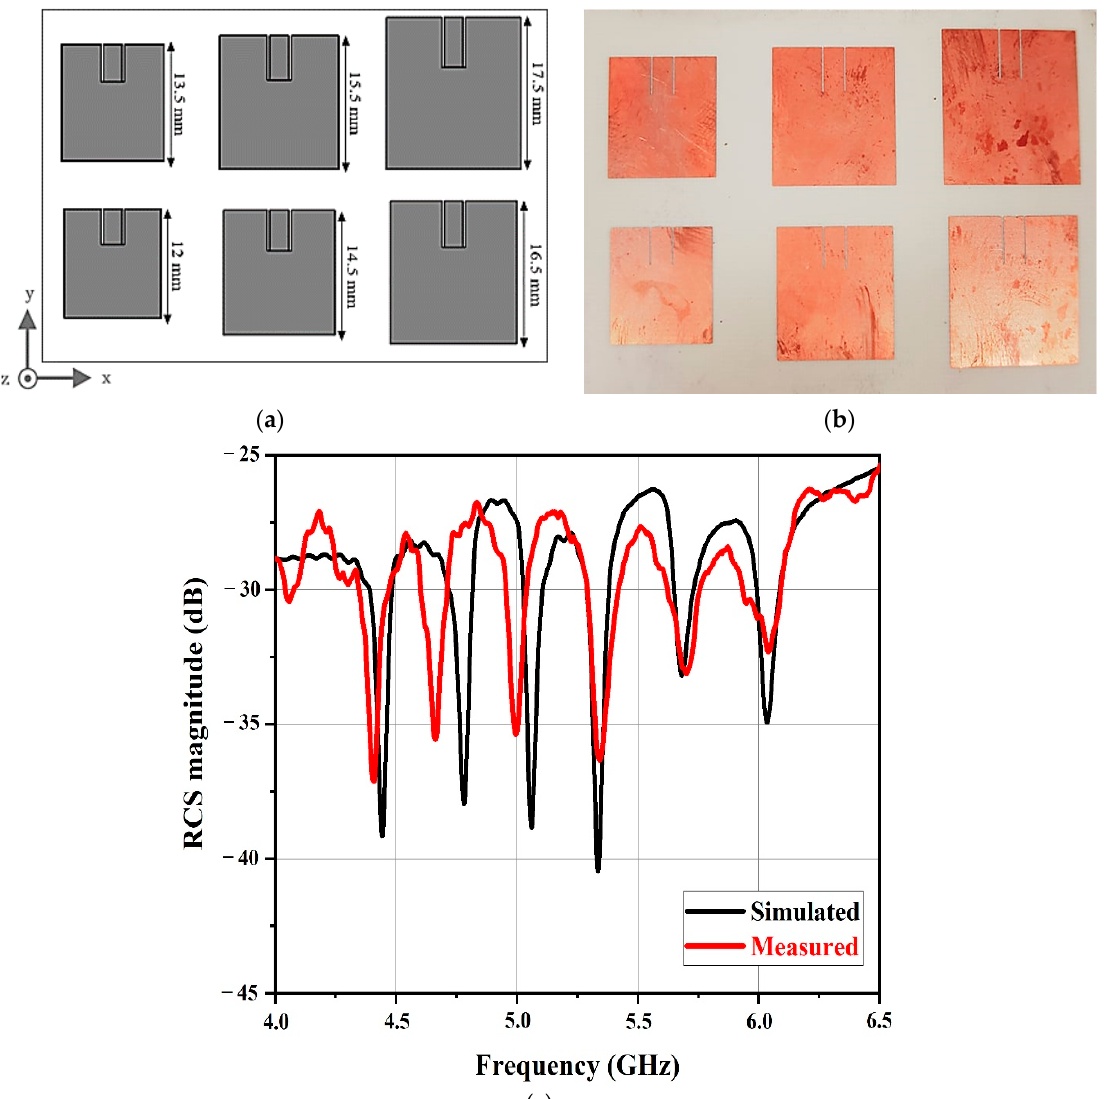
Figure 3. Dimensions of ( a ) the chipless tags loaded with resonators and ( b ) the fabricated chipless tags. ( c ) The simulated and measured radar cross section (RCS) magnitude versus frequency.